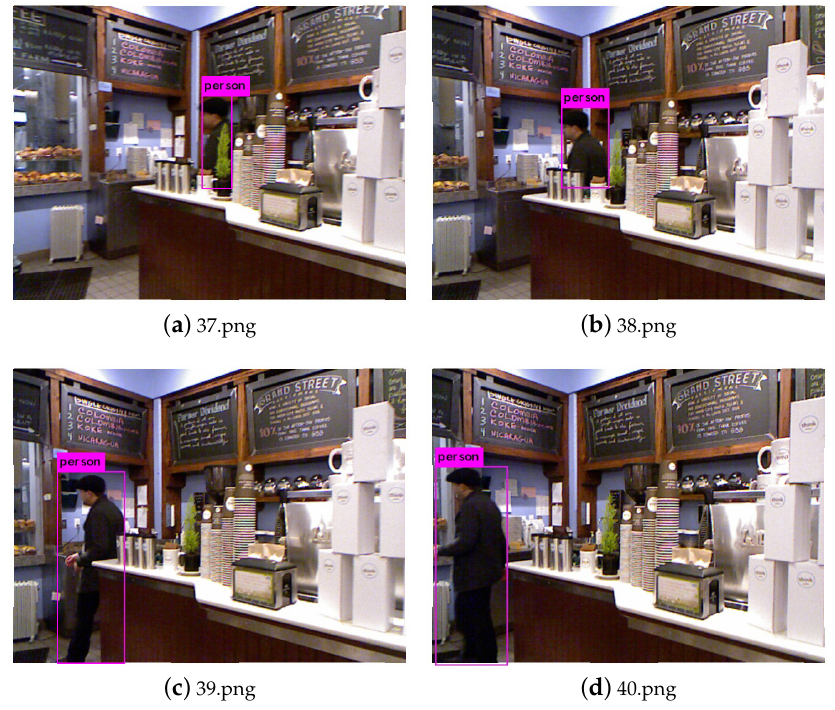
Figure 11. Object detection result of YOLOv3